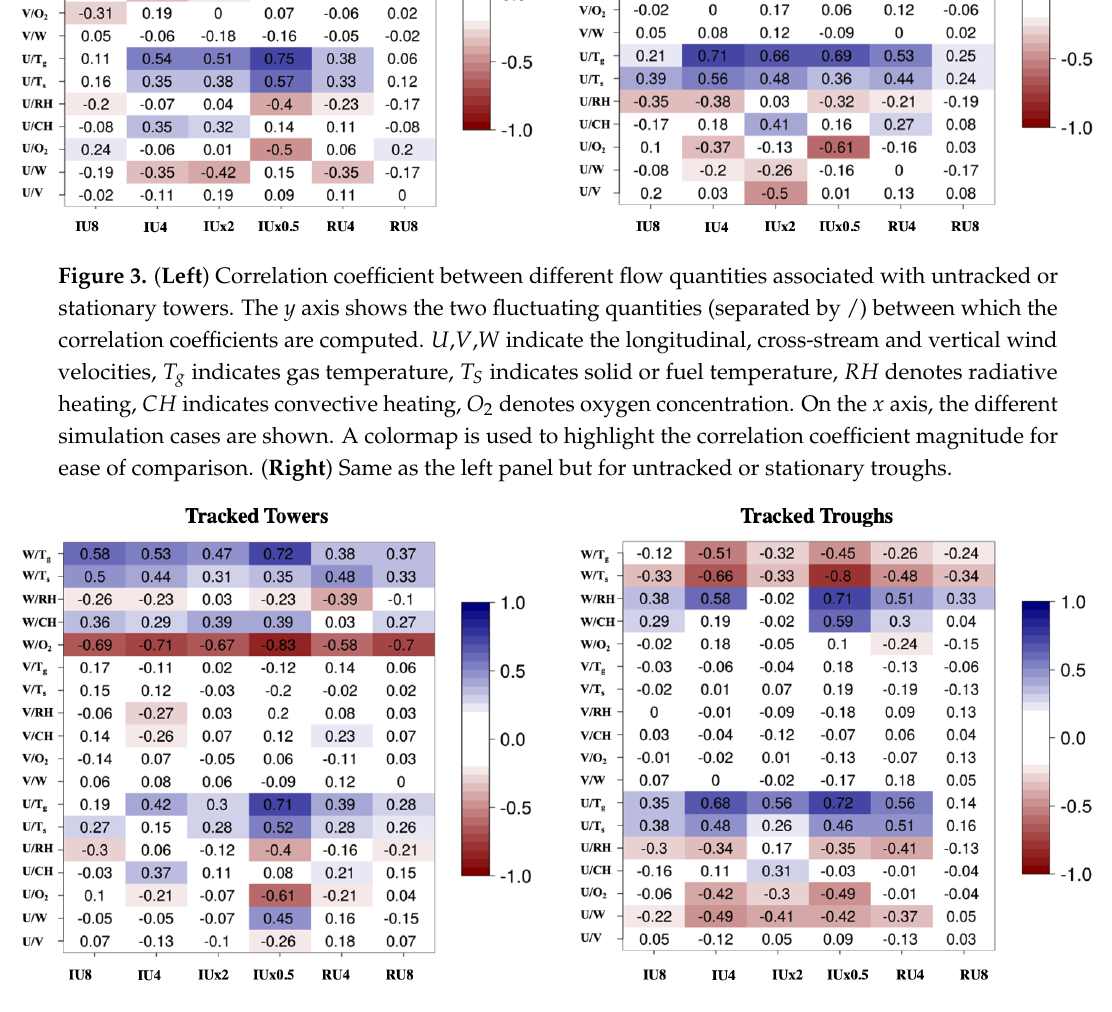
Figure 4. Same as Figure 3, but for tracked or non-stationary towers ( left ) and troughs ( right